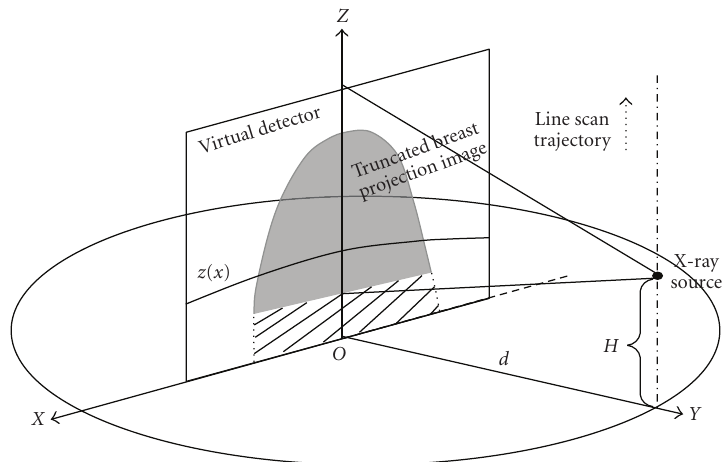
Figure 6: Illustration of straight line scanning.